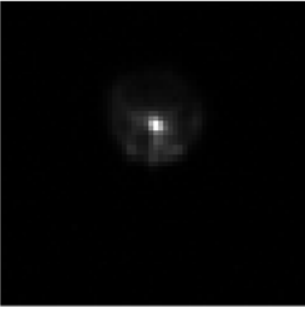
Figure 1. A representative image of the IRED used for the Camera-IRED distance estimation problem